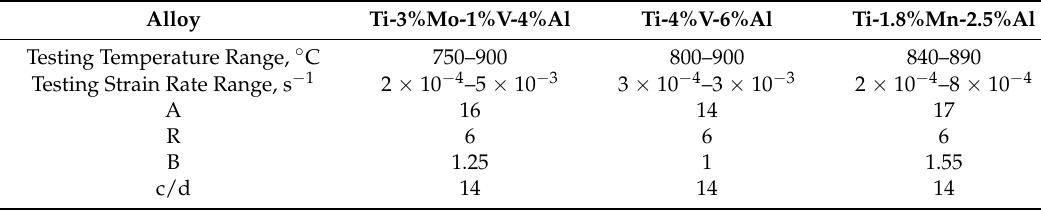
Figure 1. The superplastic tensile specimen dimensions. (c = d). Table 1. Range of testing parameters and superplastic tensile specimen dimensions, mm.